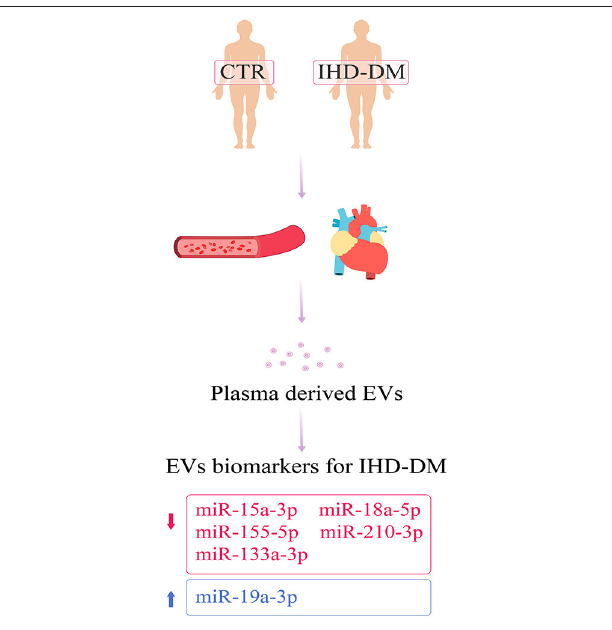
FIGURE 5 | Schematic summary for the identified EVs-derived miRNA biomarkers for IHD-DM patients.